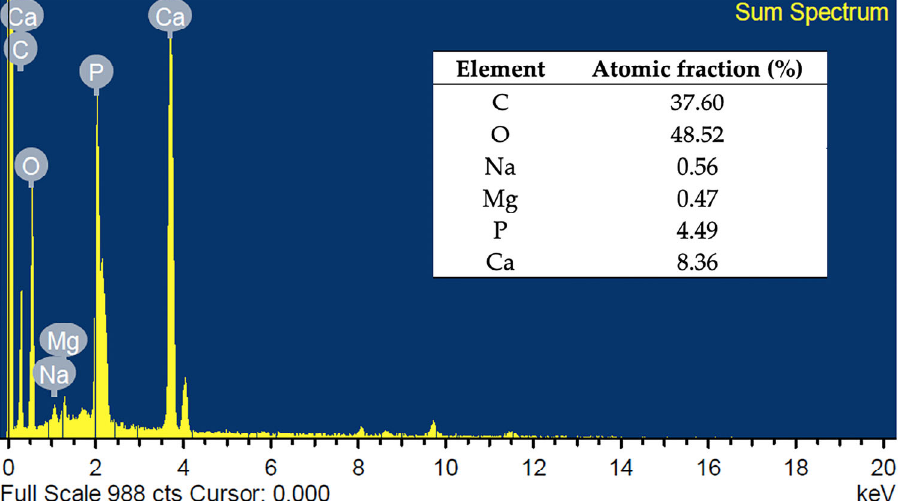
Figure 2. Elemental analysis by EDS of FSp.